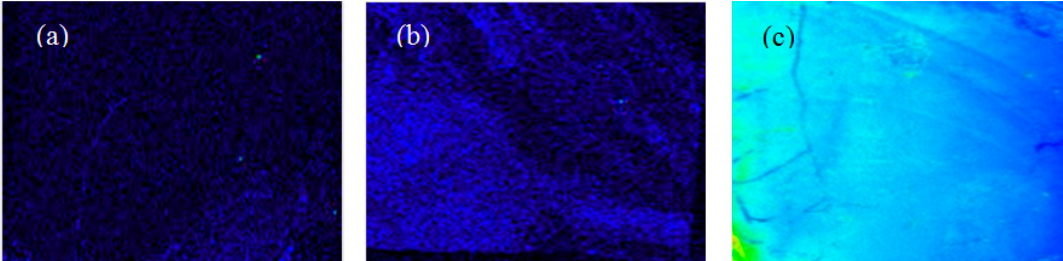
Figure 4. Fluorescence images of the binding of fluorescently labeled aptamers to Au nanostructures with/without chitosan coating. Quenching effect vs. distance between Au and dye was investigated with the fluorescent aptamers absorbed to the substrate of ( a ) Au deposited by E-beam evaporator without chitosan coating; ( b ) Au with needle-like structures without chitosan coating; and ( c ) Au with needle-like structure coated with chitosan (1000 Da).